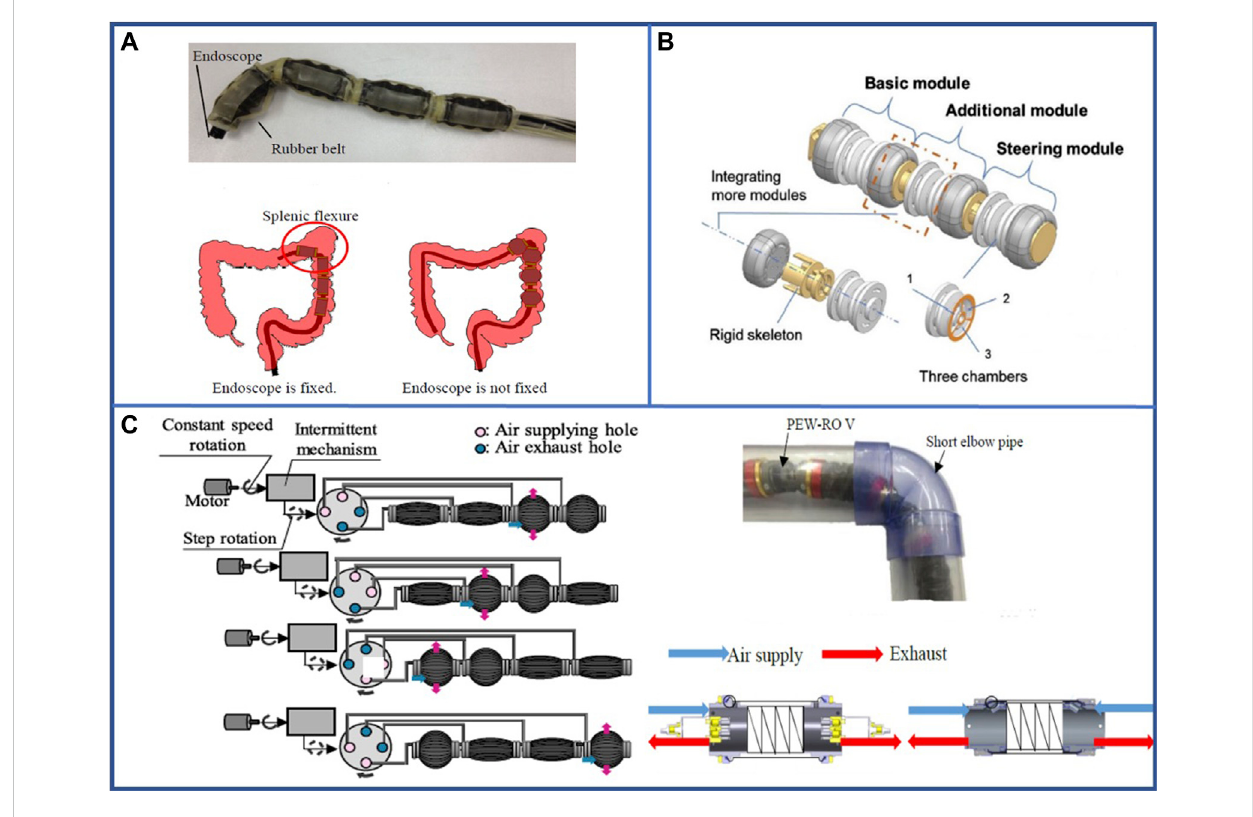
FIGURE 8 Examples of pneumatic-driven multi-segment earthworm-inspired soft robot for pipeline inspection. (A) Bending diagram of segment and experimental methodology (Yanagida et al., 2012). Reproduced from Ref. (Yanagida et al., 2012). with permission. (B) Concept design and fabrication of softrobotwithmultipleactuatorsconnectedinseriesanddemonstrationsofsteeringmodulebendingtorandomdirectionsin3Dspace(Liuetal.,2022). Reproduced from Ref. (Liu et al., 2022). with permission. (C) Appearance of robot locomotion and the new pneumatic valve (Sato et al., 2021). Reproduced from Ref. (Sato et al., 2021). with